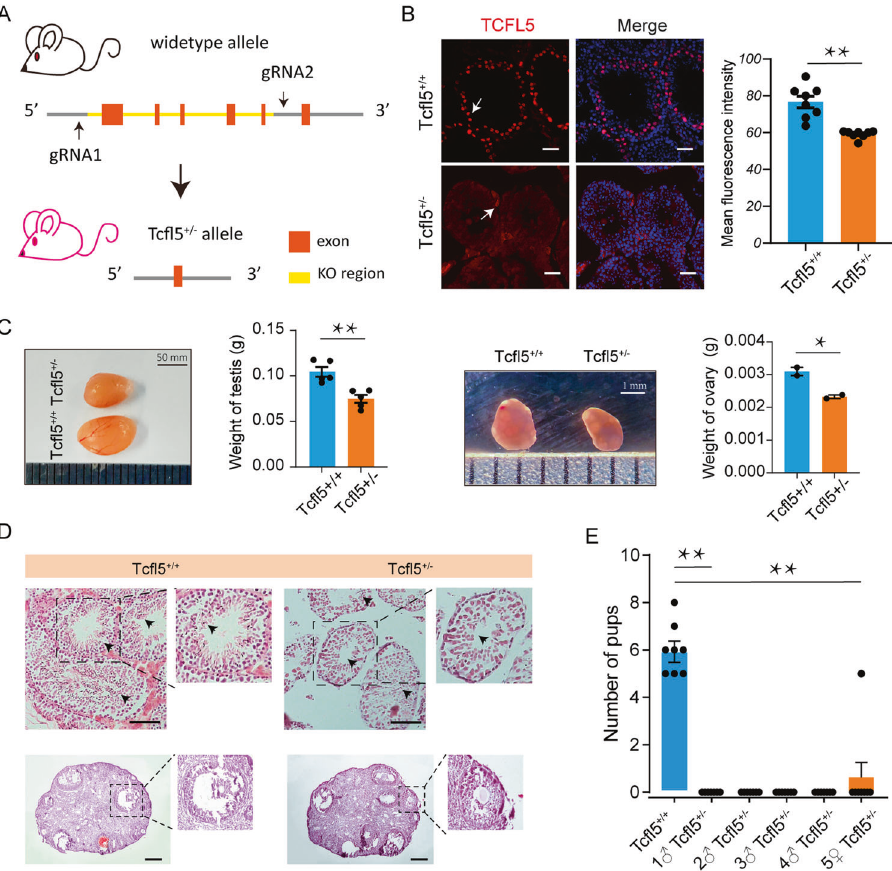
Fig. 6 Characterization of Tc fl 5 + /- mice. A Construction strategy of Tc fl 5 + / − mice; Orange represents exons; The yellow area represents the knockout area. B TCFL5 immunolocalization of germ cells in Tc fl 5 + / − male mice; bar = 50 μ m, n ≥ 3; Compared to wild type, ** means p value < 0.01. C Morphology and weight of testis (left) and ovary (right) of Tc fl 5 + / − mice; Compared to wild type, * means p value < 0.05 and ** means p value < 0.01. D Observation of testicular seminiferous tubules (up) and ovary (down) in Tc fl 5 + / − mice and normal mice according